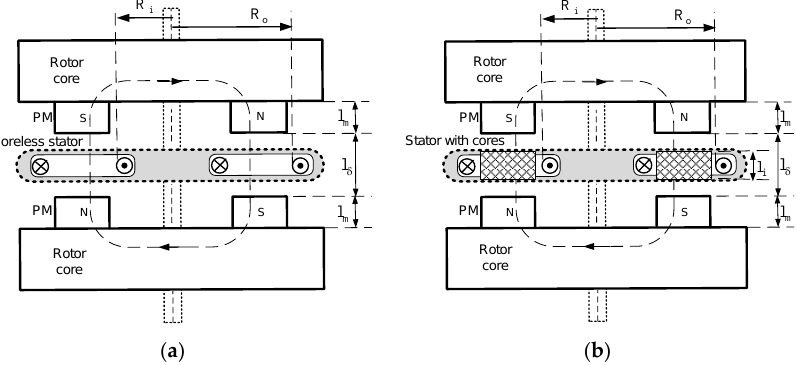
Figure 2. Design of an AFPM generator: ( a ) coreless stator; ( b ) stator with iron cores.